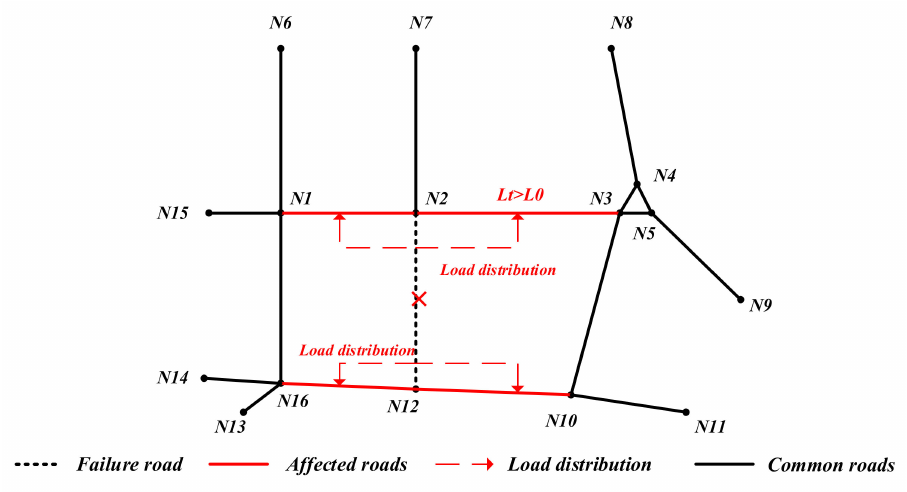
Figure 4. Road network cascade failure model